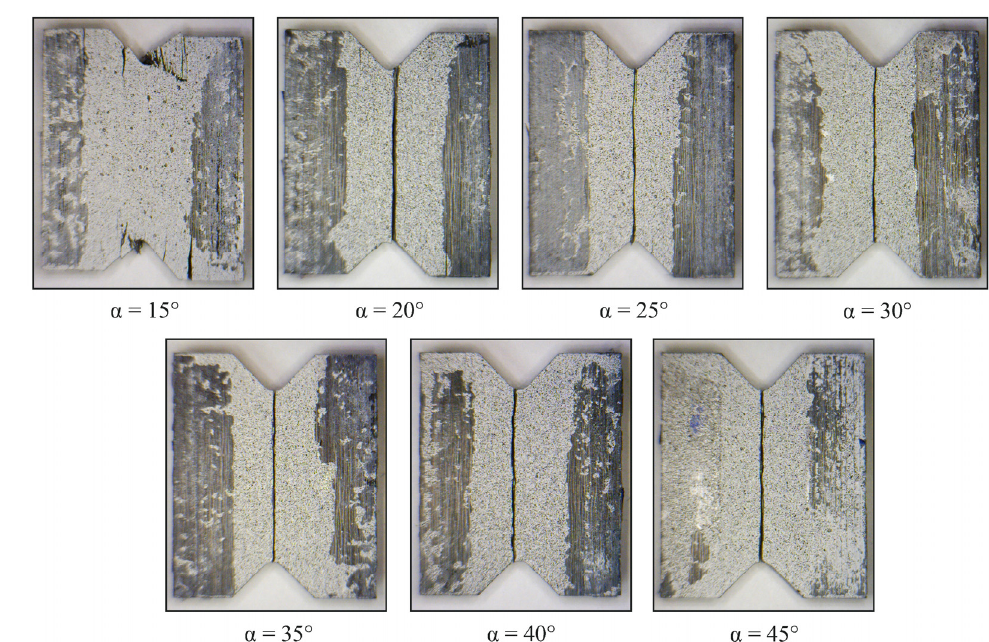
Figure 11. Failed specimens after combined compression/shear